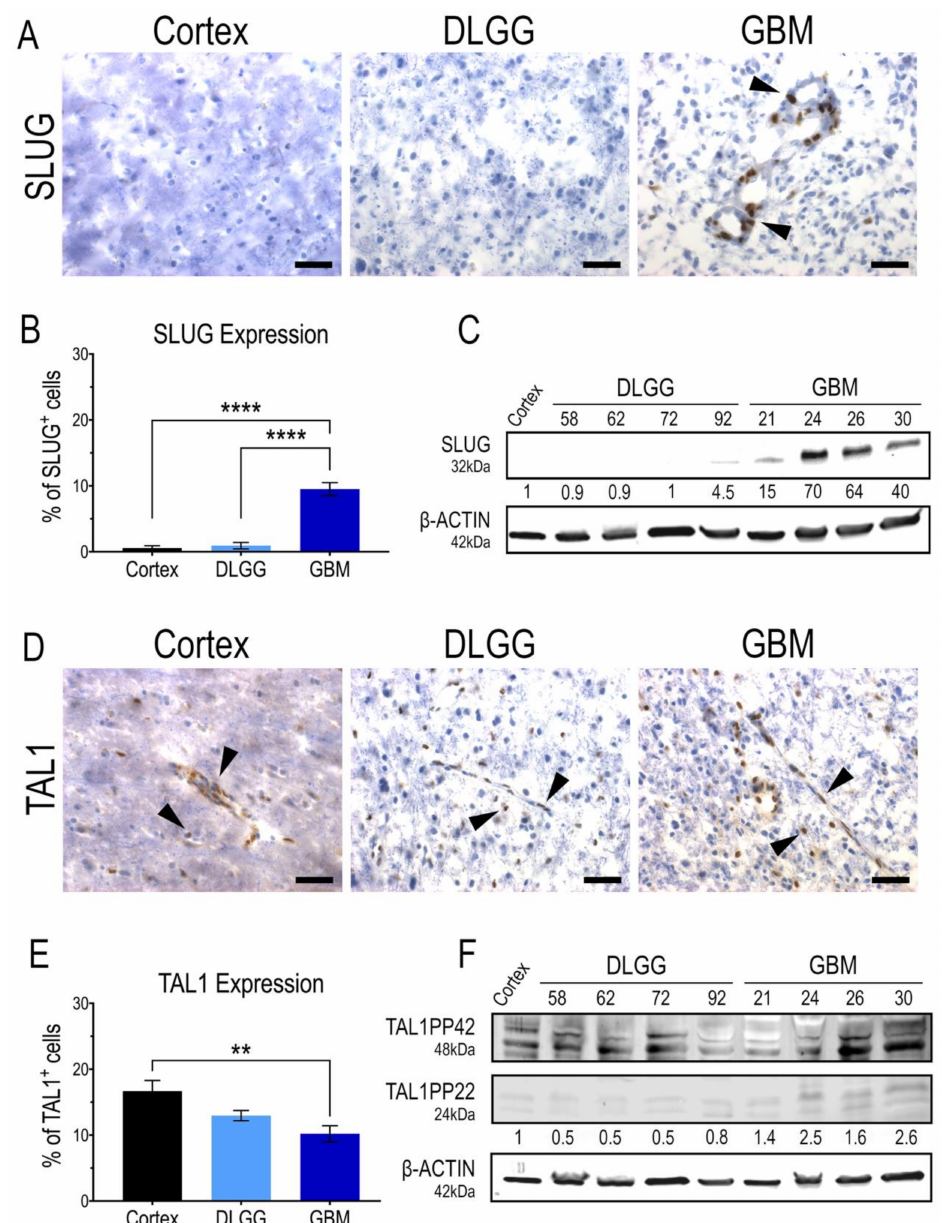
Figure 2. SLUG and TAL1 expression in human glioma samples. ( A , D ) Representative immunohistochemistry (IHC) images of SLUG and TAL1 expression in human sample cryosections, including normal cortex ( n = 1); diffuse low-grade gliomas (DLGG) ( n = 5) and glioblastomas (GBM) ( n = 5) (Tables S1 and S2). Nuclear SLUG was mainly observed in GBMs ( A ); while TAL1 expression is both cytoplasmic and nuclear and expressed in all samples ( D ). Arrowheads indicate positive cells; scales 40 µ m. ( B , E ) Quantifications of SLUG + and TAL1 + cells in these samples, ≥ 500 total cells were counted for each sample, positive cells are represented as % of total cells. Statistical analyses using ordinary one-way ANOVA tests with multiple comparisons between the mean of each group. ****, p < 0.0001; **, p < 0.01. ( C , F ) Whole tumor WB analyses of SLUG and TAL1 expression in human resections, including normal cortex ( n = 1); DLGG ( n = 4) and GBM ( n = 4). A total 50 µ g of total protein was loaded. ( F ) TAL1-PP22 isoform is upregulated in GBMs while TAL1-PP42 is expressed in all samples, using a validated antibody detecting all known isoforms of TAL1 (Table S3). Band intensities were normalized with β -actin and are shown as fold changes of the cortex